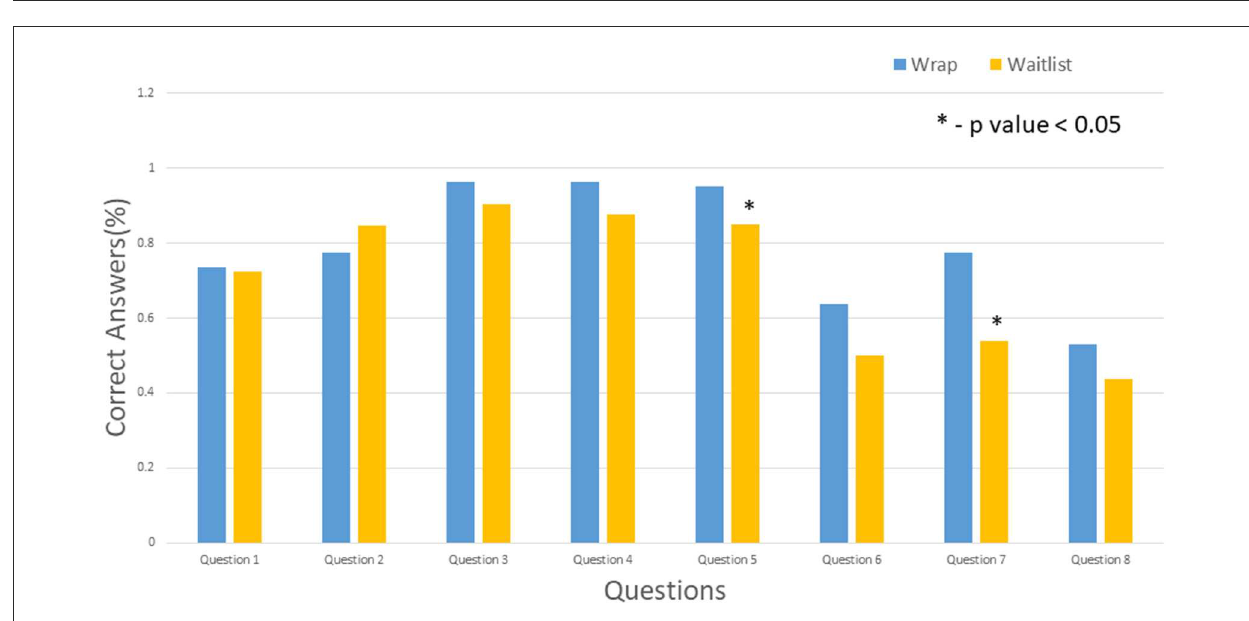
FIGURE4 Comparison of wrap and waitlist visits. Asterisk indicates P <